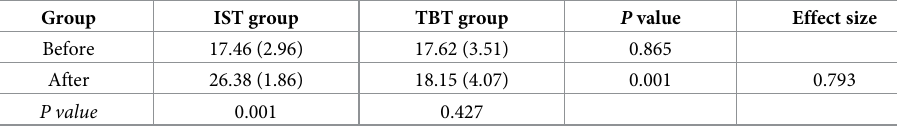
Table 4. Scores of CAIT in the IST and TBT